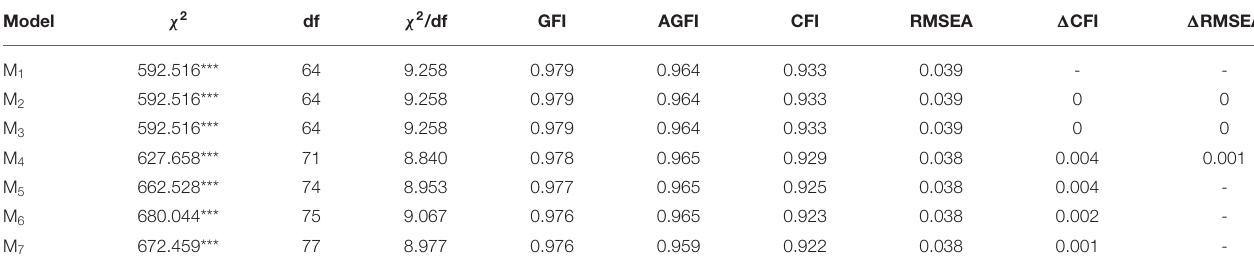
TABLE 3 | Model invariance test using multiple-group analysis. Model